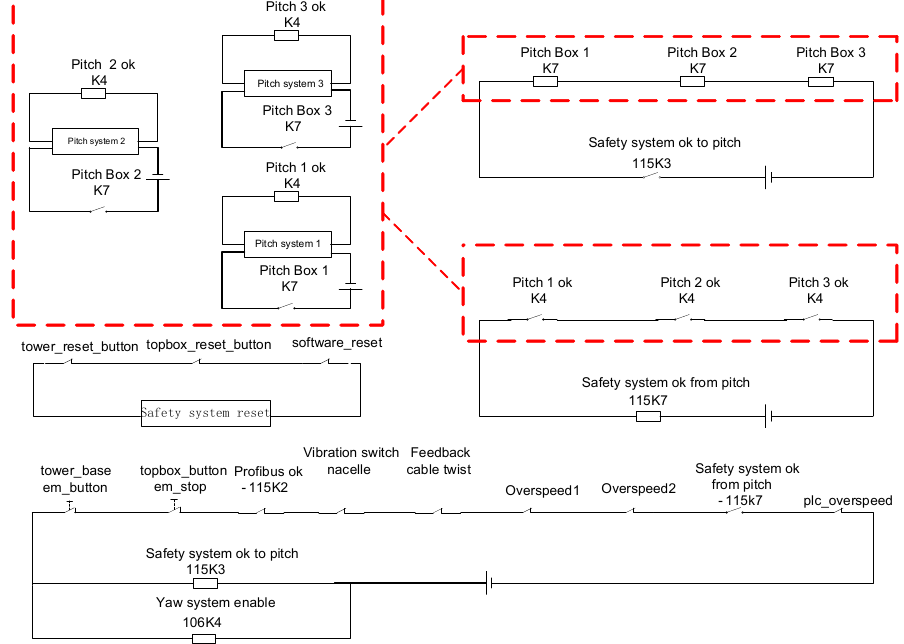
Figure 12. WT causal chains and monitoring components.